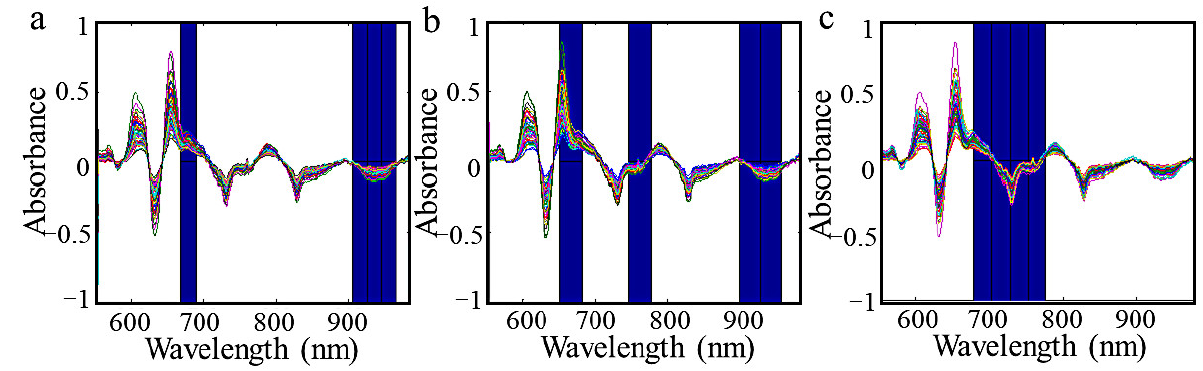
Figure 5. Optimal spectral regions selected by SI-PLS of the Haugh Unit ( a ), yolk index ( b ), weight loss rate ( c ) in egg